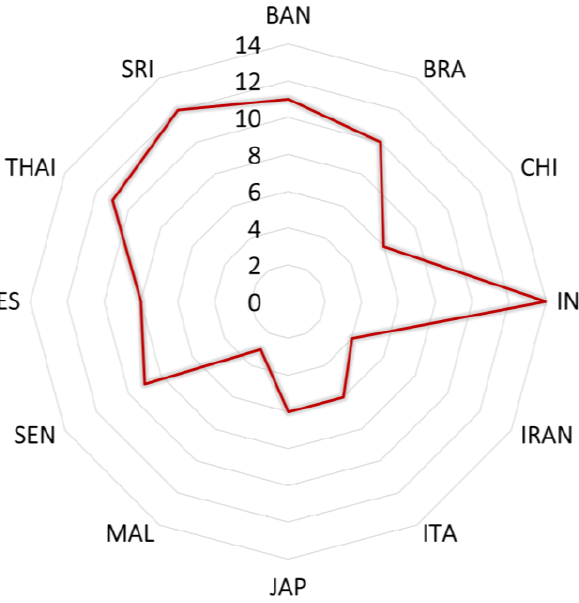
Figure 11. Countries with the highest risk of social impacts in rice production chain.